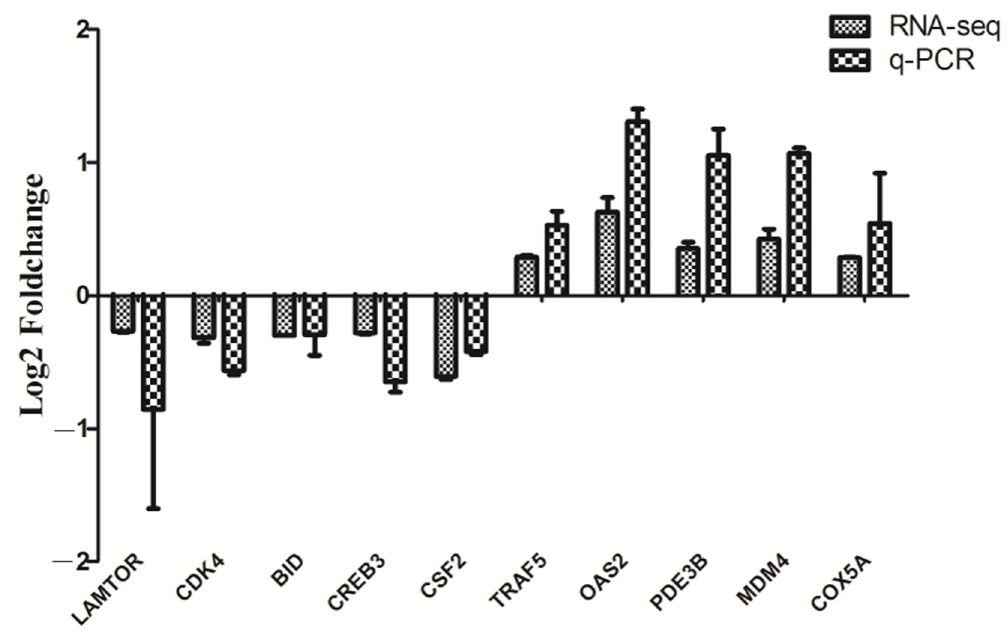
Figure 2. RT-qPCR validation on 10 randomly selected DEGs. Ten genes from RNA-seq data were randomly selected and confirmed by RT-qPCR. mRNA levels of Tas-exo and NC groups obtained from RNA-seq analysis were compared with those of RT-qPCR results. These two results were correlated using a form of log2Foldchange. Data from triplicate-independent experiments were evaluated using online software. Relative DEG abundance was calculated using 2 − ∆∆ Ct method.